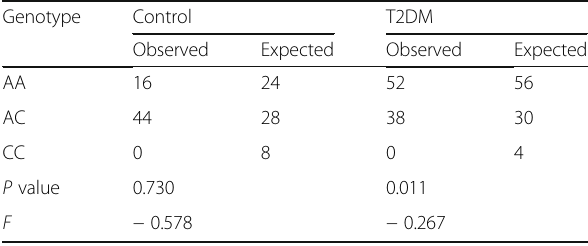
Table 1 Hardy-Weinberg equilibrium for the BMP15 gene Genotype